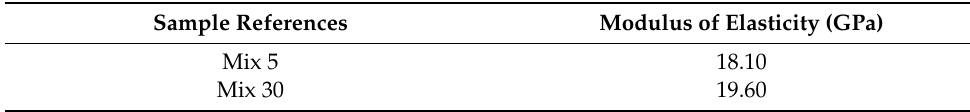
Table 3. Modulus of Elasticity (MOE) at 28-day of